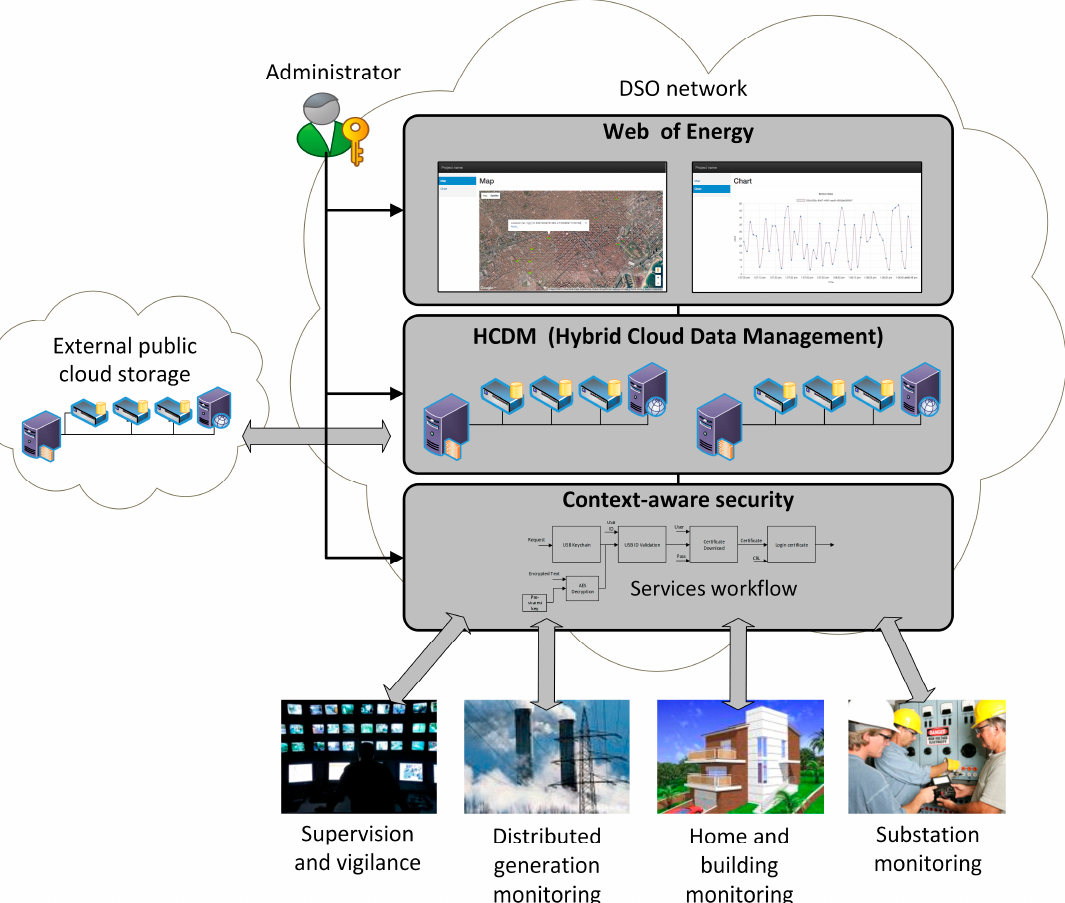
Figure 1. Main modules: Context-aware security, Hybrid Cloud Data Management and Web of Energy.